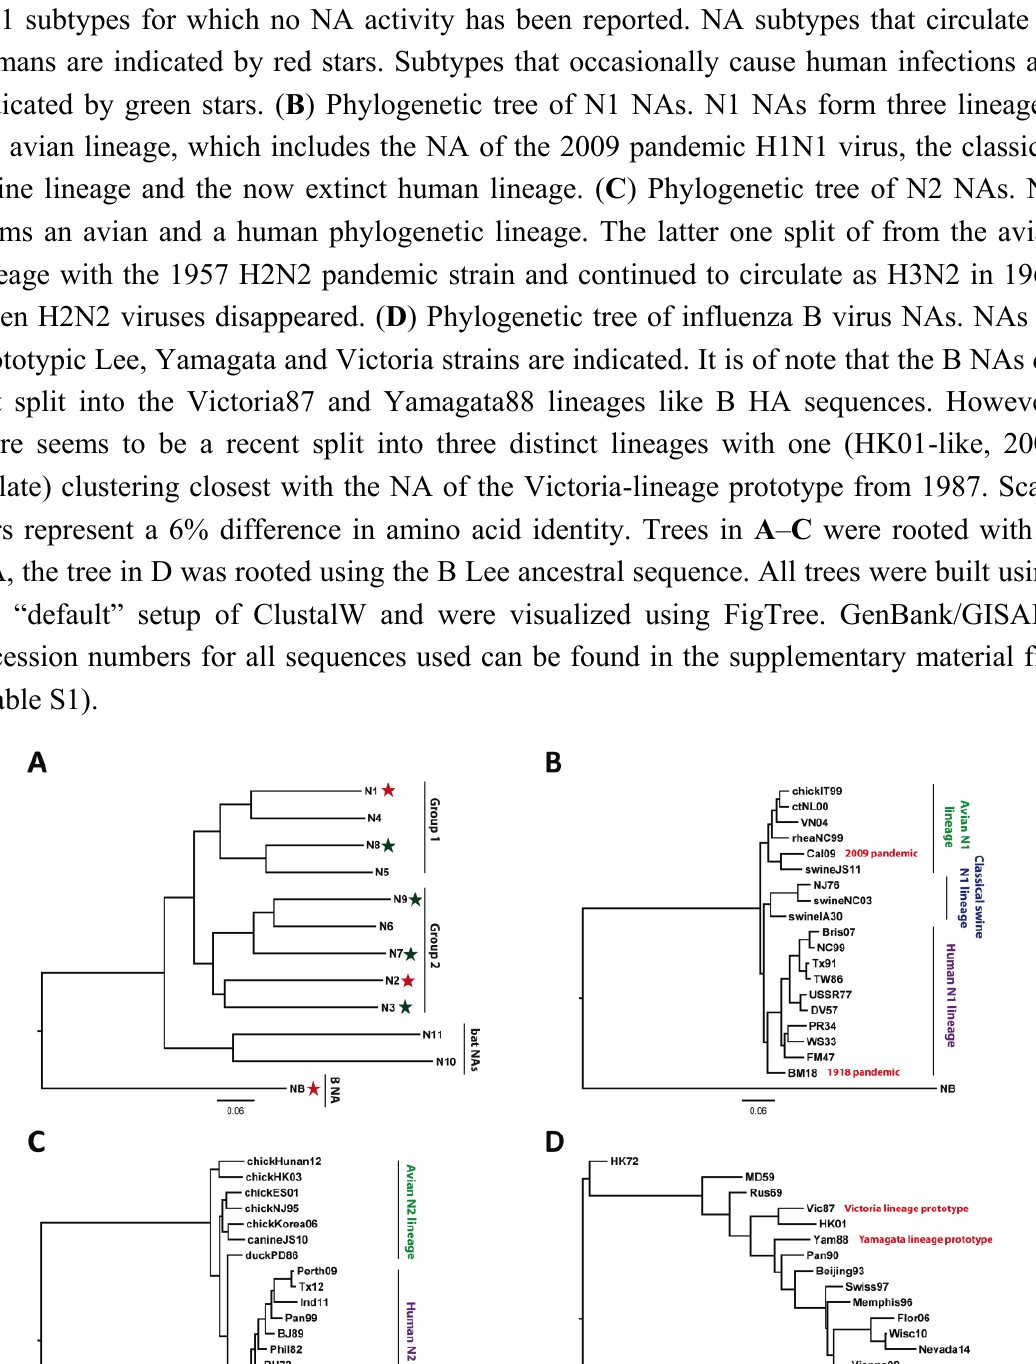
1. Phylogenetic relationships of influenza virus neuraminidase